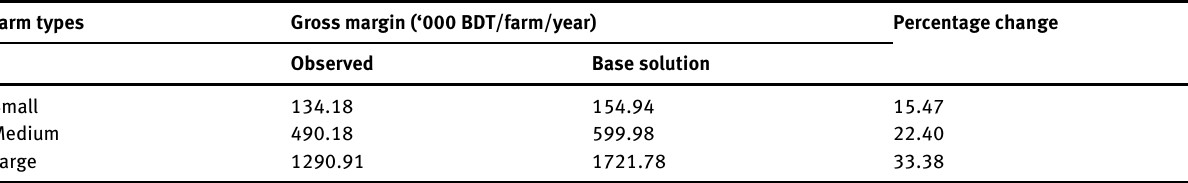
Table 3: Overall gross margin in observed and base solution level